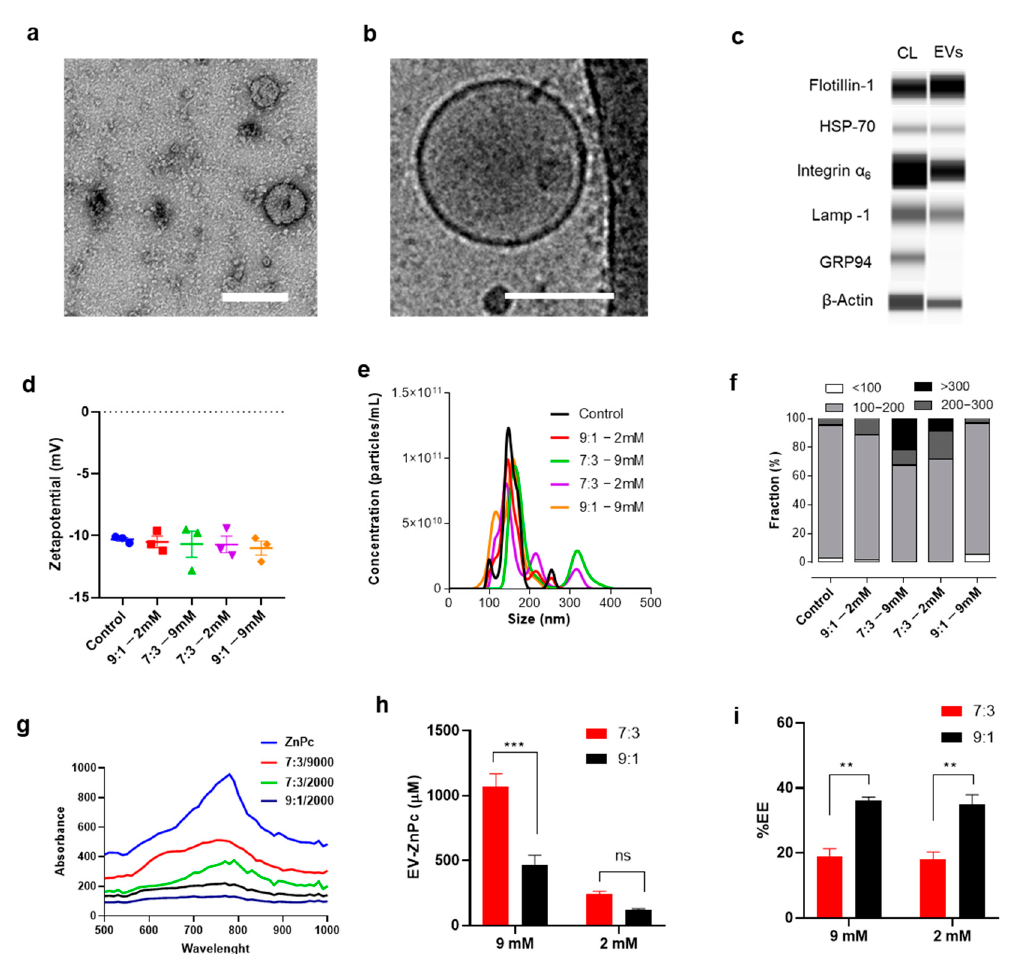
Figure 1. Preparation of EV-ZnPc. Representative ( a ) TEM, ( b ) cryo-TEM micrograph, and ( c ) capillary electrophoresis (CL = cell lysates) of EVs isolated from B16F10. EVs were loaded with different concentrations of ZnPc and characterized by ( d ) laser doppler anemometry and ( e ) NTA. ( f ) The total number of EVs obtained by NTA was used to calculate the proportion of different size fractions. UV-vis spectroscopy was used to obtain the ( g ) absorption curves, ( h ) concentration of samples, and ( i ) encapsulation efficiency (EE). Scale bars are 100 nm. *** p < 0.001; ** p < 0.01; mean ± SEM; n = 3).